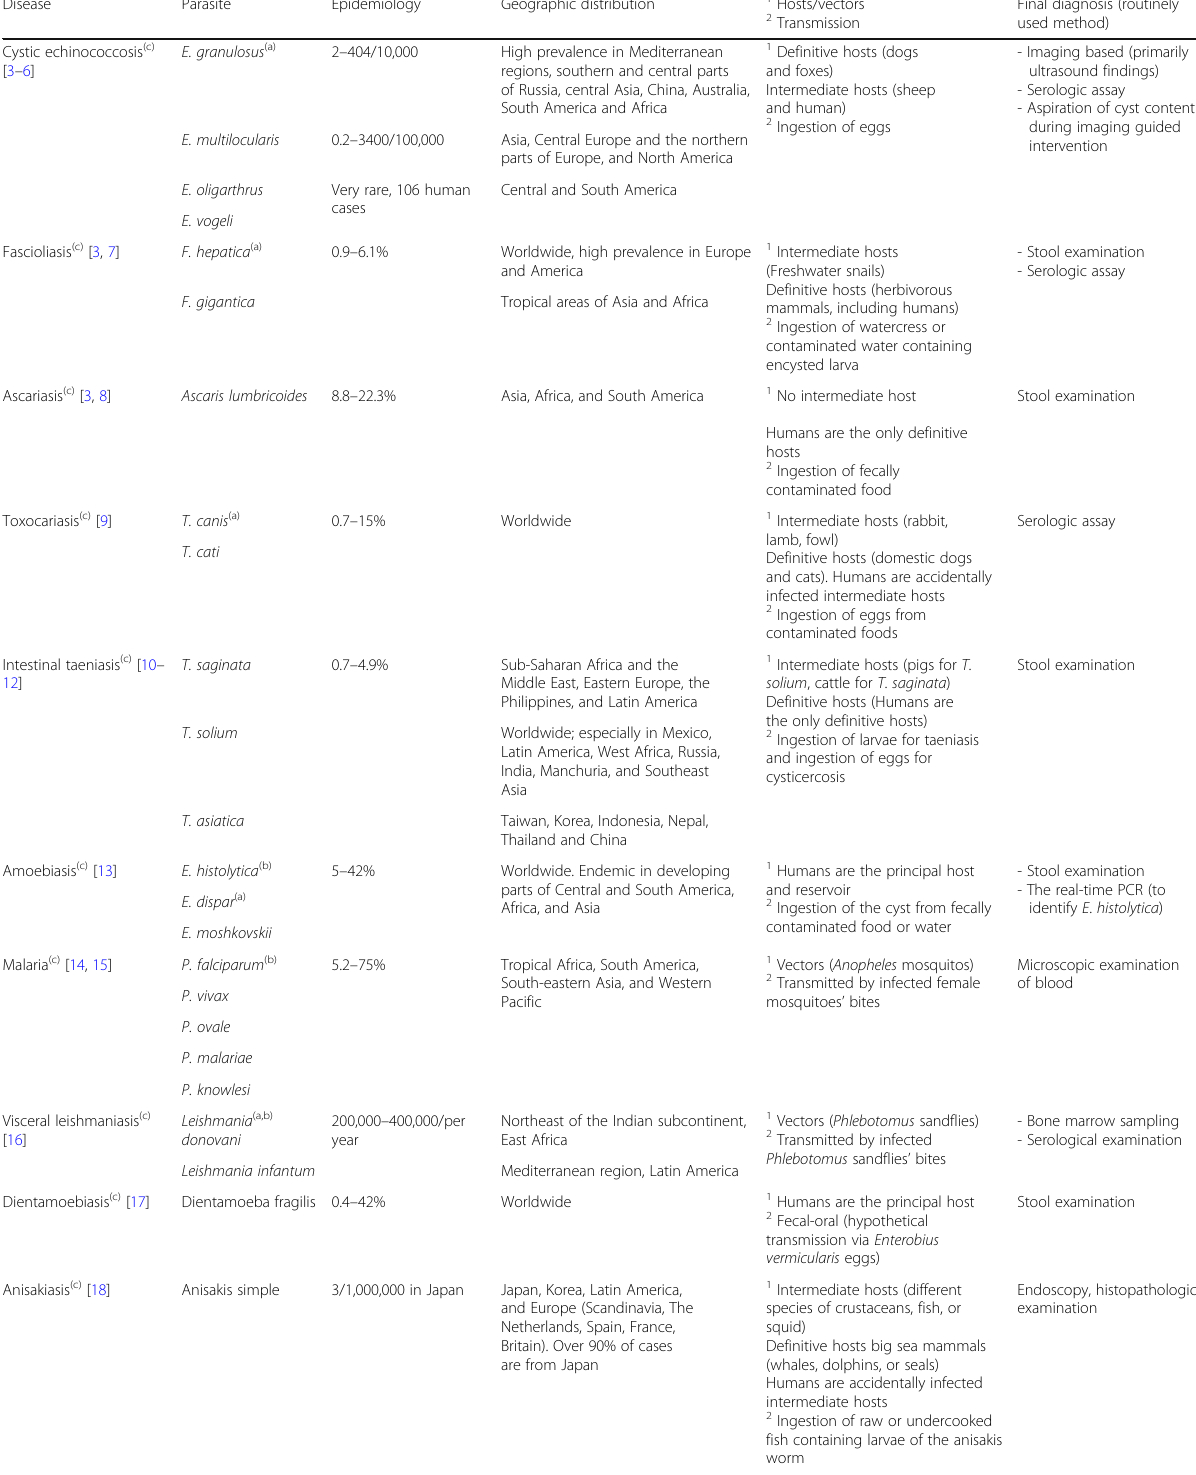
Table 1 Epidemiologic aspects, route for transmission, and methods used for the definitive diagnosis of the parasitic diseases